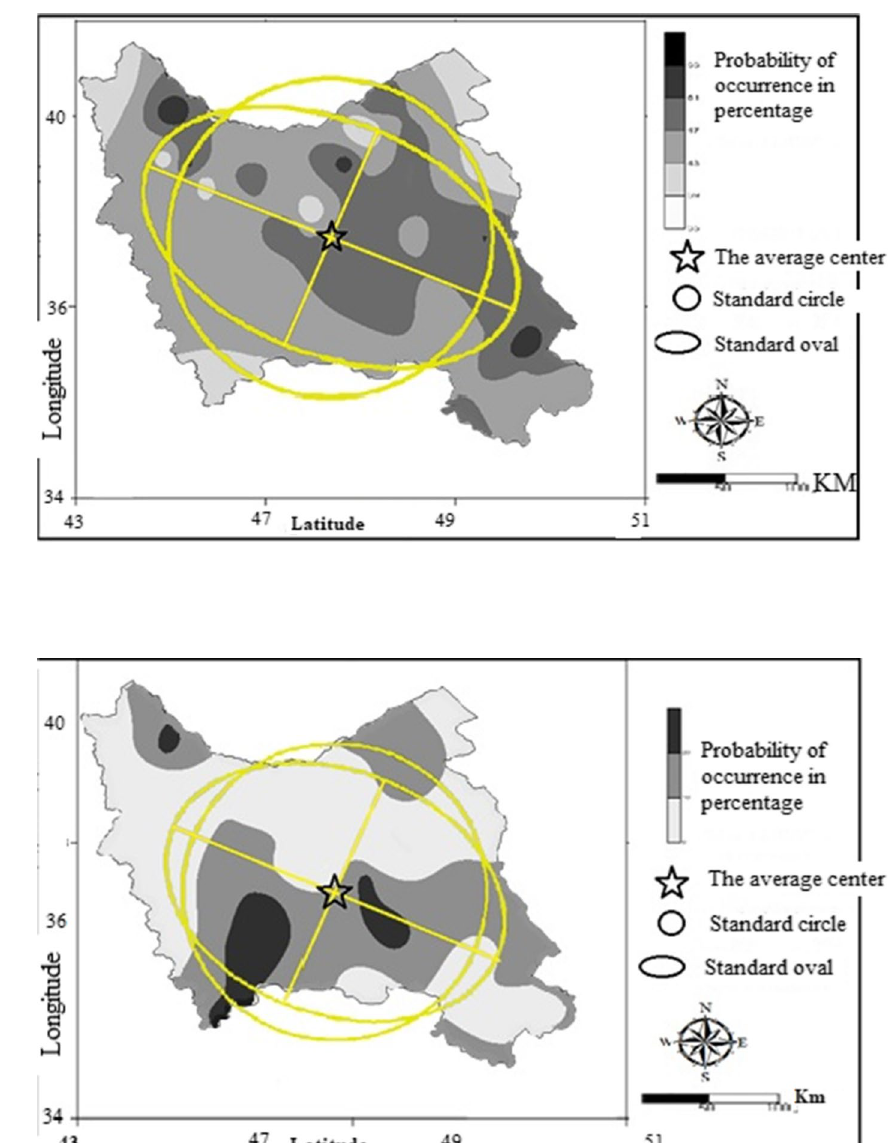
Fig. 6 Probability of weak wet-